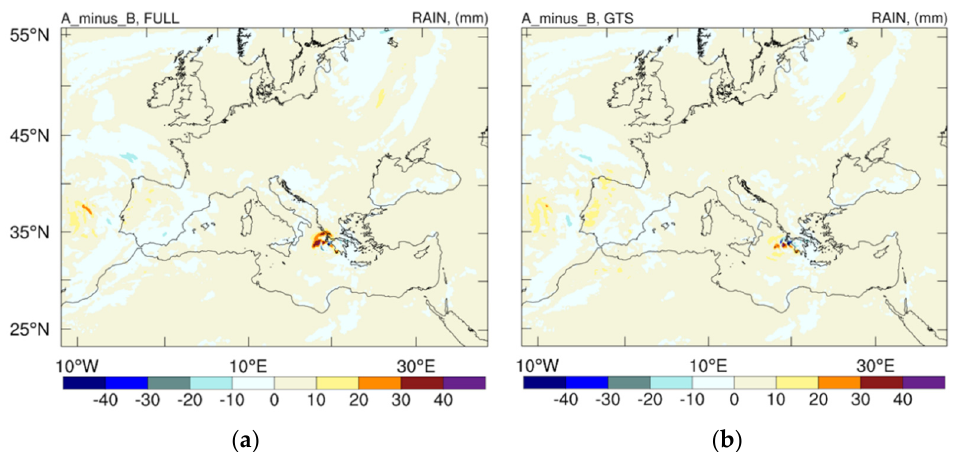
Figure 12. Analysis minus background for the accumulated 6-hour precipitation in mm between 00 and 06 UTC on 18 September 2020 for ( a ) the FULL experiment and ( b ) the GTS experiment. The 2 m temperature and 10 m wind speed A_minus_B are also presented in